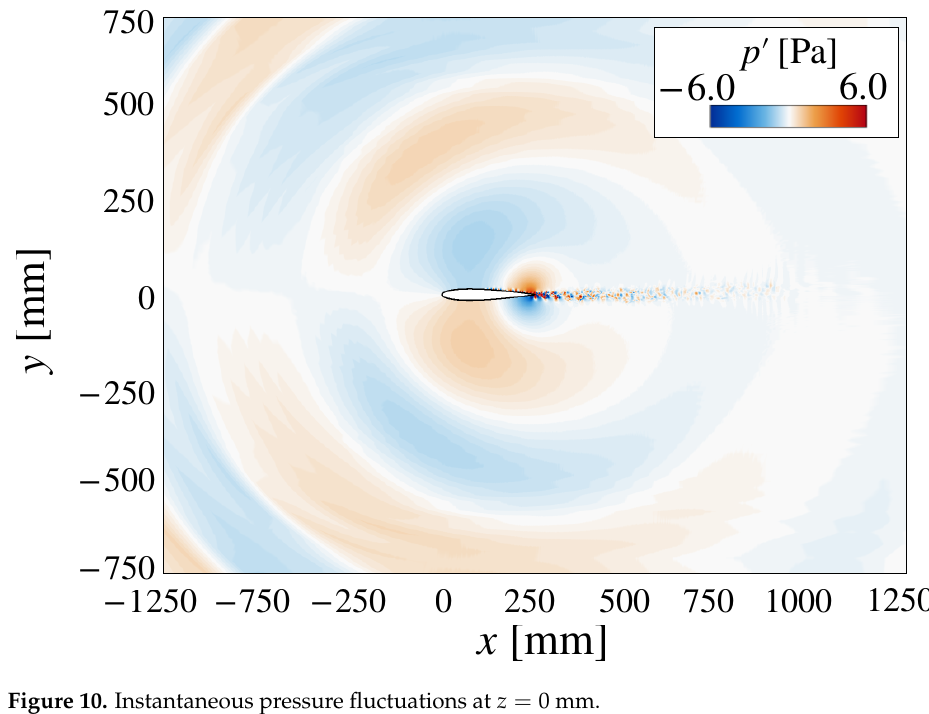
Figure 10. Instantaneous pressure fluctuations at z = 0 mm.